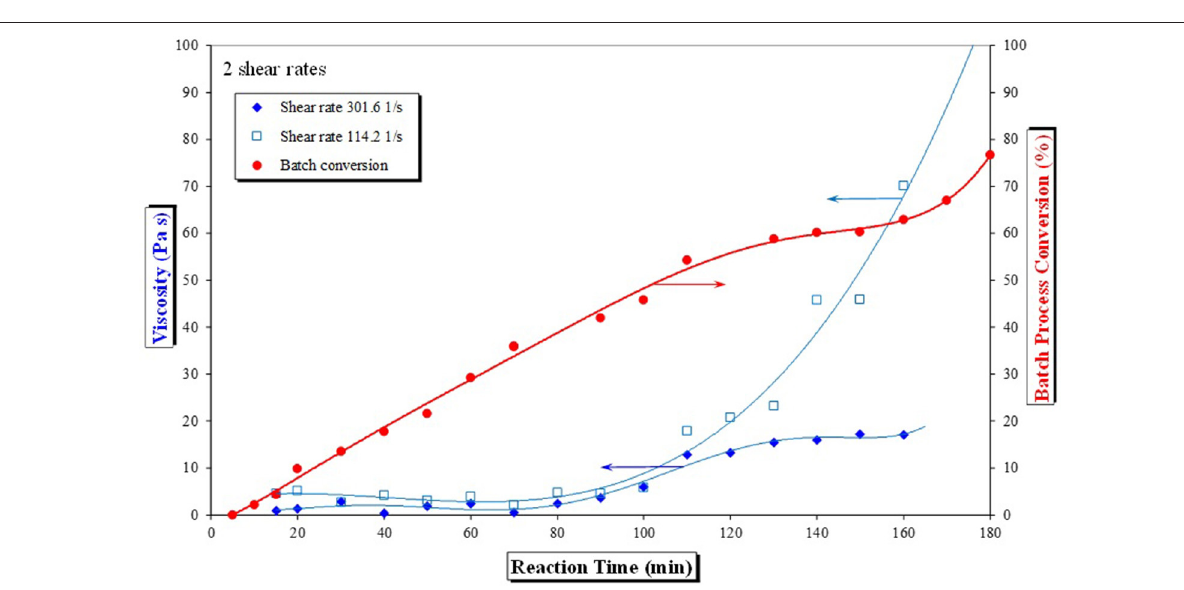
FIGURE 6 | Batch reaction profile and sample viscosities at shear rates of 114.2 and 301.6 s − 1 (initial conditions T = 90 ◦ C, 83% wt/wt monomer, 1.4% wt/wt